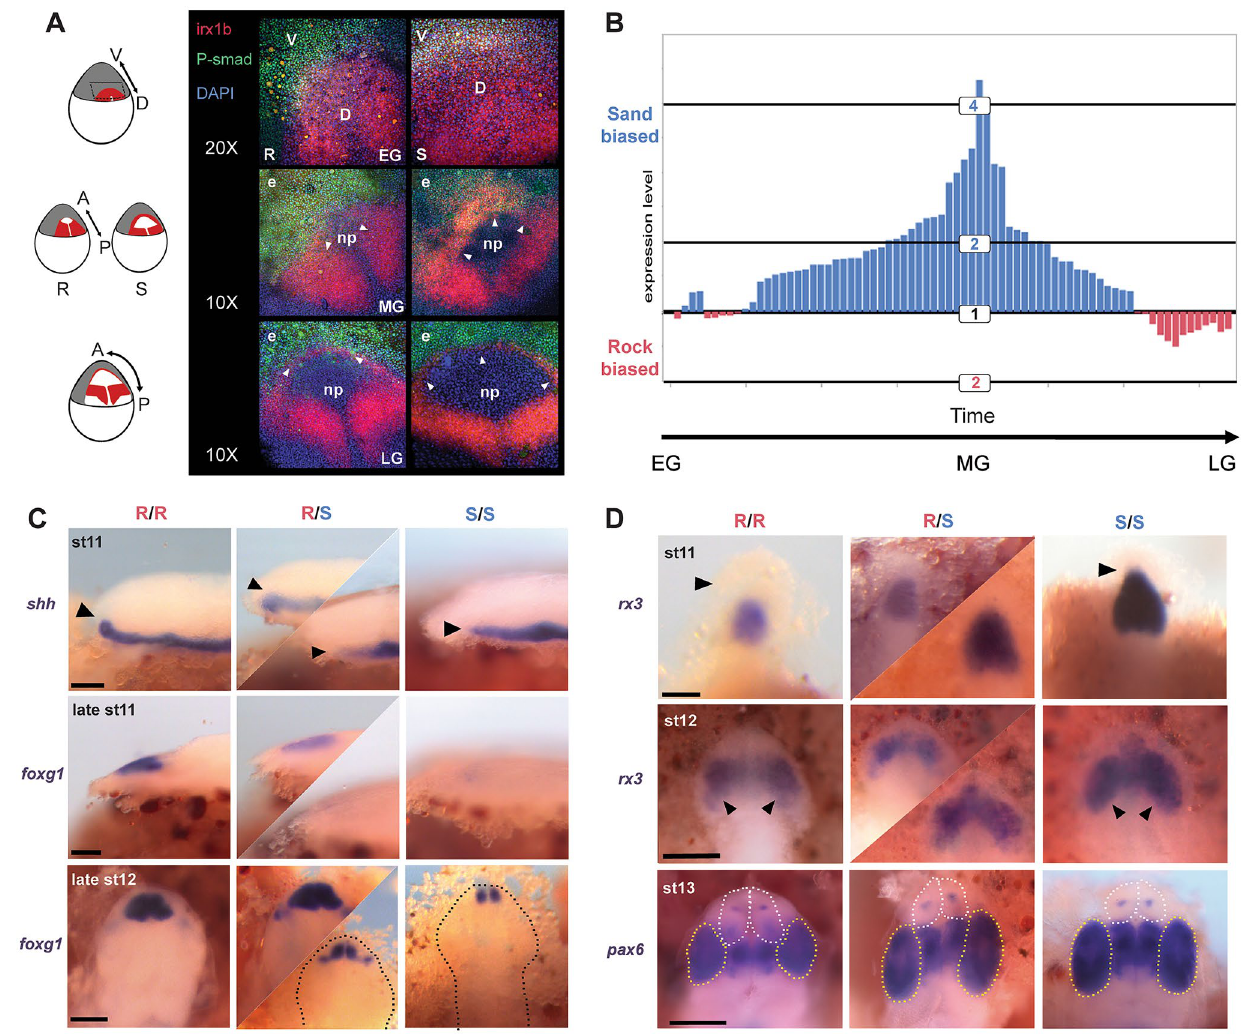
Figure 2. A gastrula-stage map of forebrain diversification. ( A ) Double in situ hybridization— immunohistochemistry to visualize irx1b expression (red) and BMP [PSMAD] activity (green) across the stages of cichlid gastrulation; DAPI in blue. Three rows represent early, mid and late gastrulation (EG, MG, LG) in embryos of rock- (R) and sand-dwelling (S) species. Sand-dwellers show expanded irx1 expression in the dorsal portion of the embryo at EG, expanded irx1b expression in the anterior domain at MG (arrowheads) and clear PSMAD activity from the developing neural plate (np) earlier in LG (arrowheads). e epidermis. Schematics at left show irx1b expression domains in red, on cartoons of cichlid embryos. ( B ) Relative expression of rock (red) and sand (blue) irx1b alleles, sampled from 74 heterozygous rock-X sand-F 2 embryos, across the stages of gastrulation. F 2 embryos were sampled at stage 9 (gastrulation). Because Malawi cichlid species are maternal mouthbrooders and eggs are fertilized in batches per brood, each brood’s embryos vary in timing of fertilization by up to 4 h. Embryos within broods can therefore be sub-staged in gastrulation (see “Materials and methods” section). Each bar on the plot represents the relative allelic expression of sand- and rock- irx1b in a heterozygous F 2 individual. Quantification of allele-specific expression (ASE) shows that levels are sand-biased, and that this effect is strongest in MG. ( C ) In situ hybridization of shh and foxg1 , during neurula stages, showing development of the telencephalon in rock-X sand-F 2 embryos, indexed for irx1b genotype. F 2 individuals homozygous for rock- irx1b alleles (R/R) show a more dorsal progression of shh expression (black arrowheads), an earlier and a larger expression domain of the telencephalon marker foxg1 . The top two rows are lateral views; bottom row is a dorsal view. Dotted lines demarcate the outline of the embryo in dorsal view. Heterozygous individuals exhibit greater variation in expression domains (middle columns), indicating that genetic factors other than variants in irx1b contribute to this phenotype. ( D ) In situ hybridization for rx3 and pax6 , during neurula stages, chart the development of the eye field in rock- X sand- F 2 embryos indexed for irx1b genotypes. F 2 individuals homozygous for sand- irx1b alleles (S/S) show larger domains of rx3 (black arrowheads) and larger eyes ( pax6 , also marked by yellow dotted line), but smaller telencephala (white dotted line). All panels are dorsal views. Heterozygous individuals exhibit greater variation in expression domains (middle columns), indicating that genetic factors other than variants in irx1b contribute to this